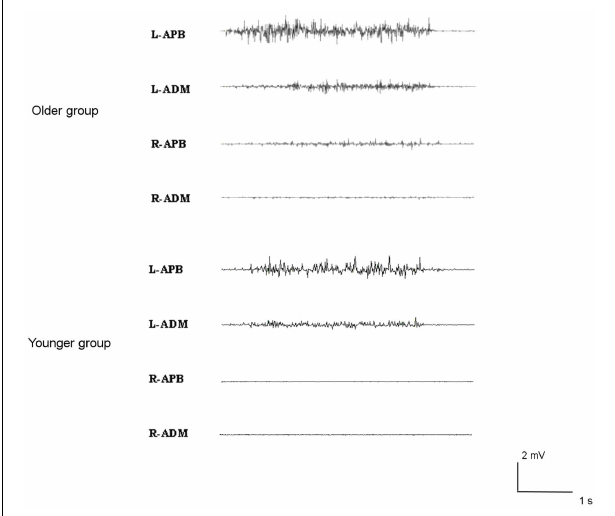
FIGURE 3 | Examples of mirror movements in an older subject (upper traces), compared to a young subject (lower traces) .